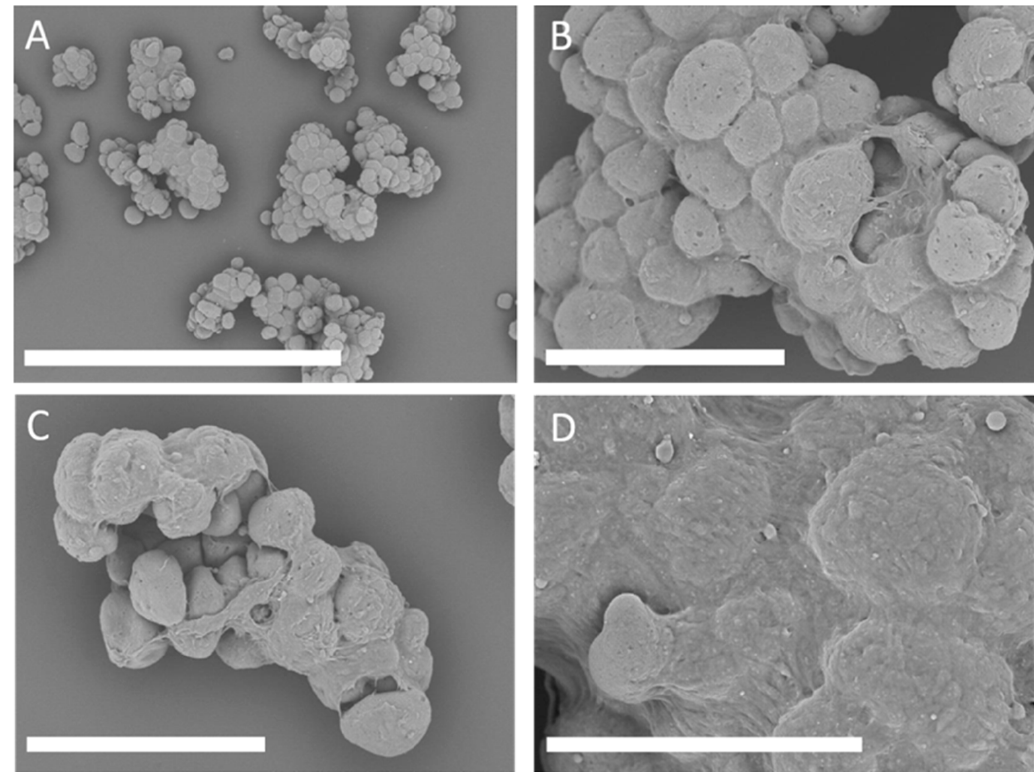
Figure 7. SEM microphotographs to confirm the presence of ASC52Telo cells on MC BR44 surface after four days of culture in static conditions. Fold magnification: ( A ): 50×, scale bar 2 mm ( B , C ): 250×, scale bar 300 µm ( D ): 500×, scale bar 200 µm. Interestingly, the cells are tiny and packed together, which is a feature often found with undifferentiated/immature cells.